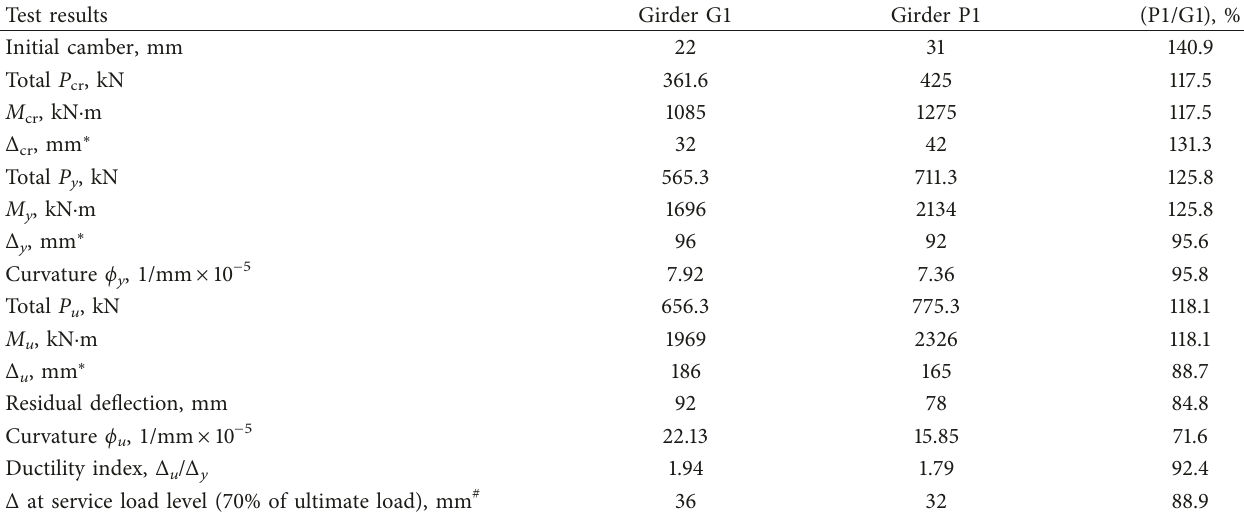
Table 5: Summary of test results for girders G1 and P1.